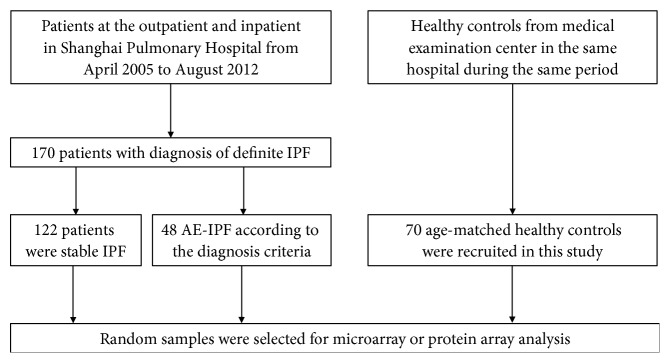
Flow chart of patient enrollment.